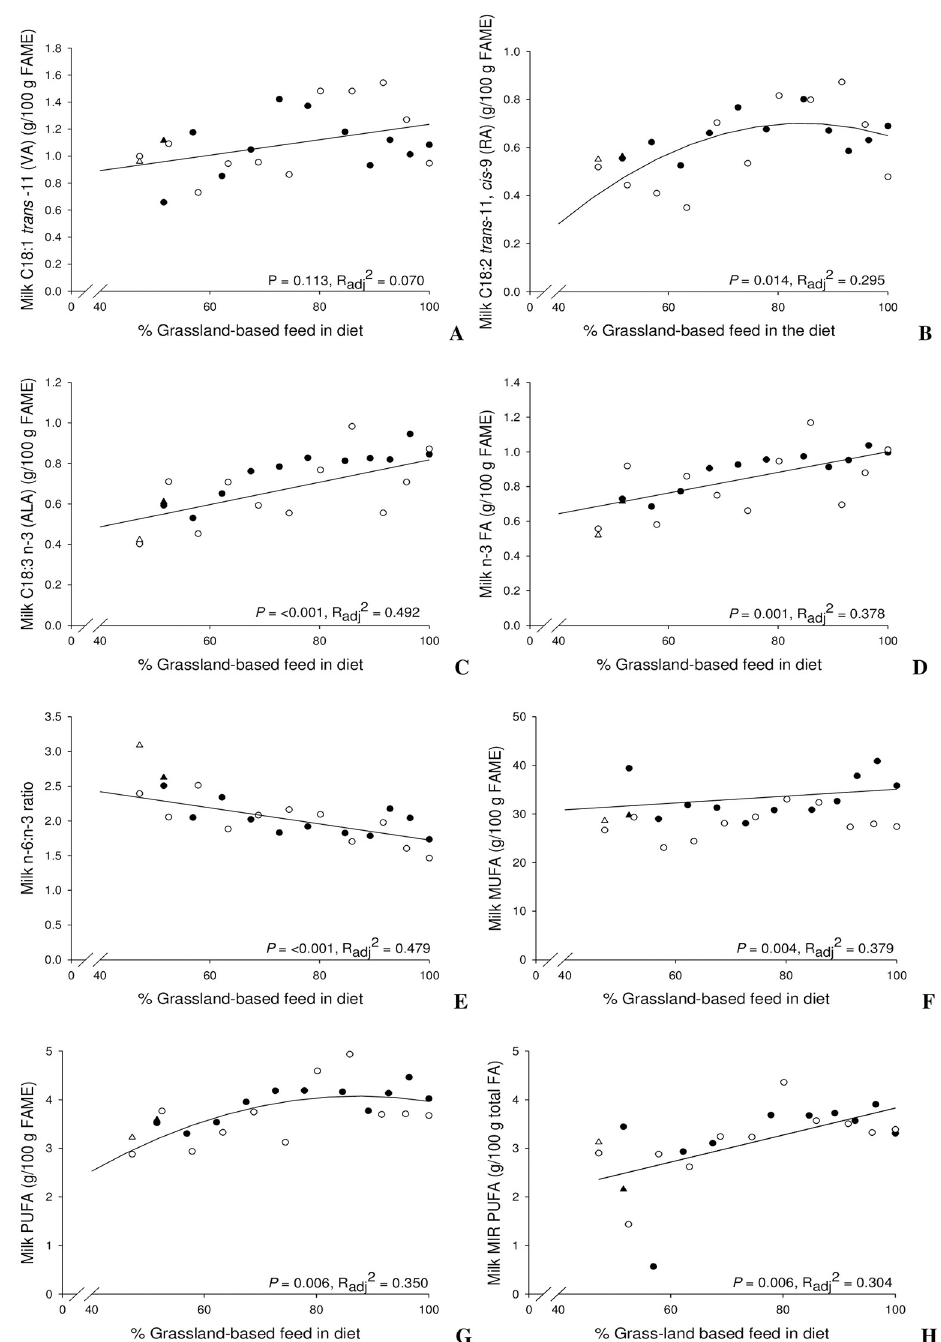
Fig 2. Proportions of C18:1 trans-11 (VA) (A), C18:2 trans-11, cis-9 (RA) (B), C18:3 n-3 (ALA) (C), n-3 (D), n-6: n-3 ratio (E), MUFA (F) and PUFA (G) of total FAME, and MIR-estimated PUFA (H) in relation to the percentage of grassland-based feed in the dairy cow’s diet. Cows supplemented with β -carotene are depicted as triangles and were excluded from the regressions. Harvest years are presented separately (2018 as filled data points; 2019 as hollow data points). The slope of the regression, P -values ( P ) and adjusted R-squared (R adj 2 ) represent the regression model across all data (for details of regression models see Tables 2, 4, 6).